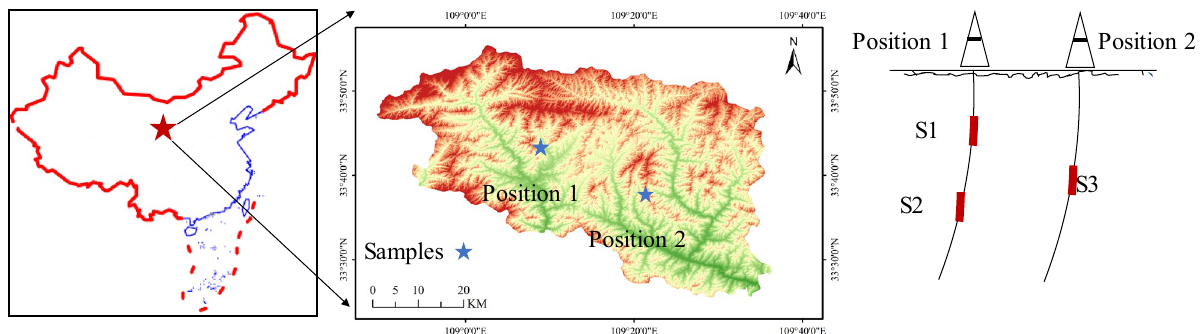
Figure 1. The location of the studied agricultural fields in Zhashui, China. (generated from publicly available geoscience data on the DataV.GeoAtlas platform; http:// datav. aliyun. com/ portal/ school/ atlas/ area_ gener ator, last access: 19 July